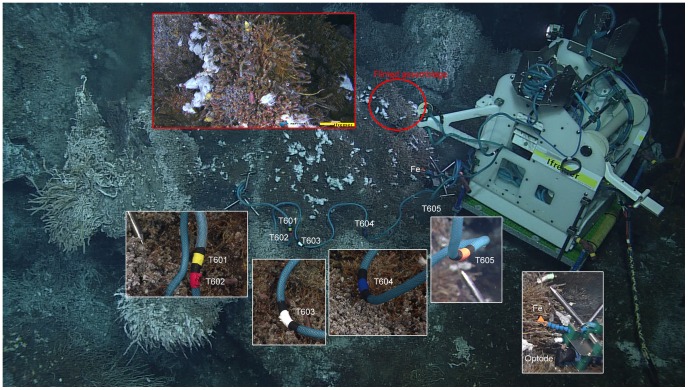
TEMPO-mini module in situ.TEMPO-mini in situ, at Grotto hydrothermal vent at 2186 m depth. Insets show the filmed assemblage as well as the deployed environmental probes. T60x were the temperature probes and CHEMINI Fe and optode sampling inlets were mounted on a tripod deployed below the filmed assemblage.